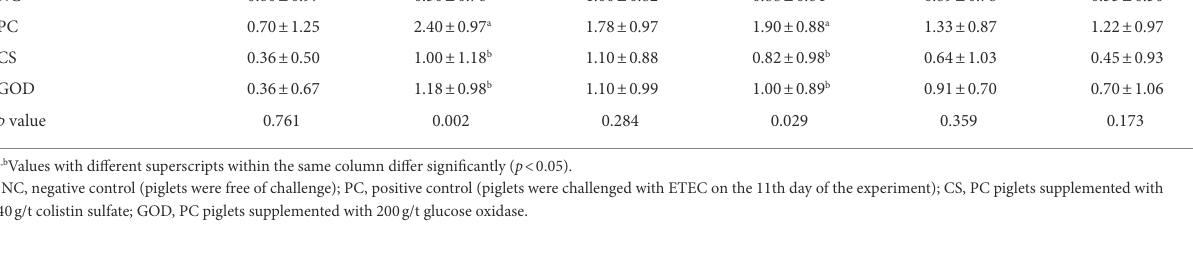
TABLE 5 Effect of dietary treatments on serum parameters 1 in piglets challenged by enterotoxigenic Escherichia coli (ETEC). Treatments